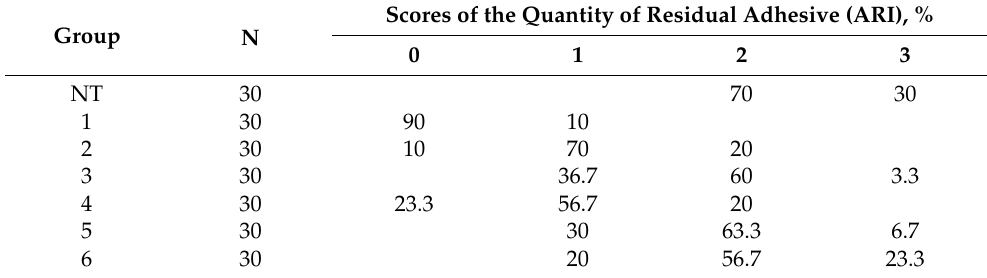
Table 2. Scores of the quantity of residual adhesive (ARI) for each group. Group N